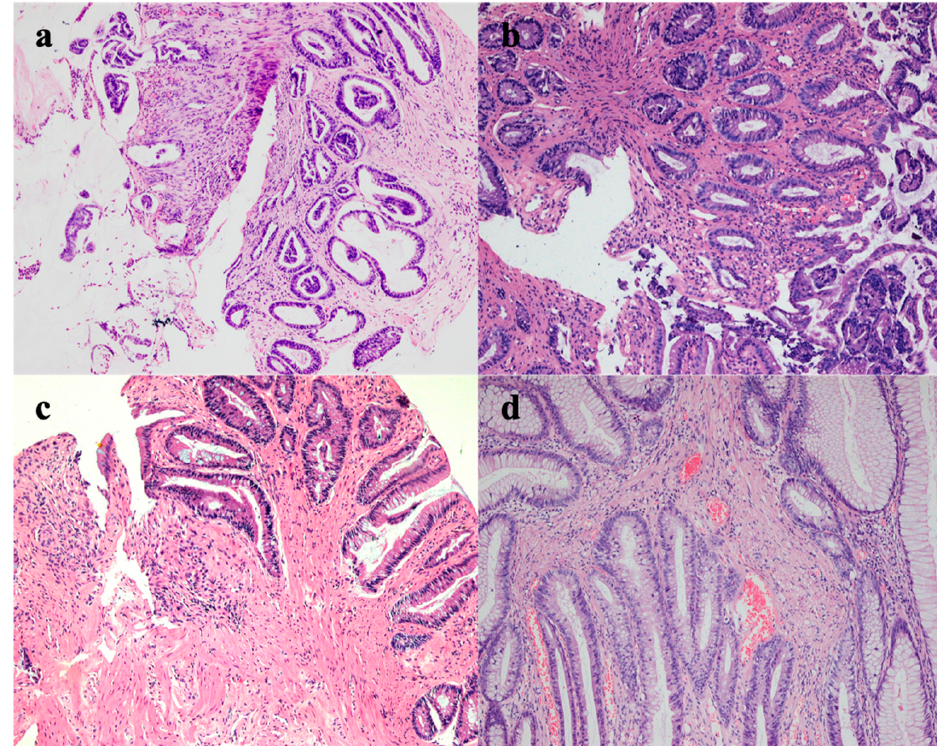
Figure 2. Histologic examination: ( a – c ) histologic biopsy in other hospitals: highly distorted and expanded glandular bodies with atypical changes in glandular epithelial cells (magnification: ×100); ( d ) histologic biopsy in our hospital: microvascular hyperplasia and musculomucosal hyperplasia.